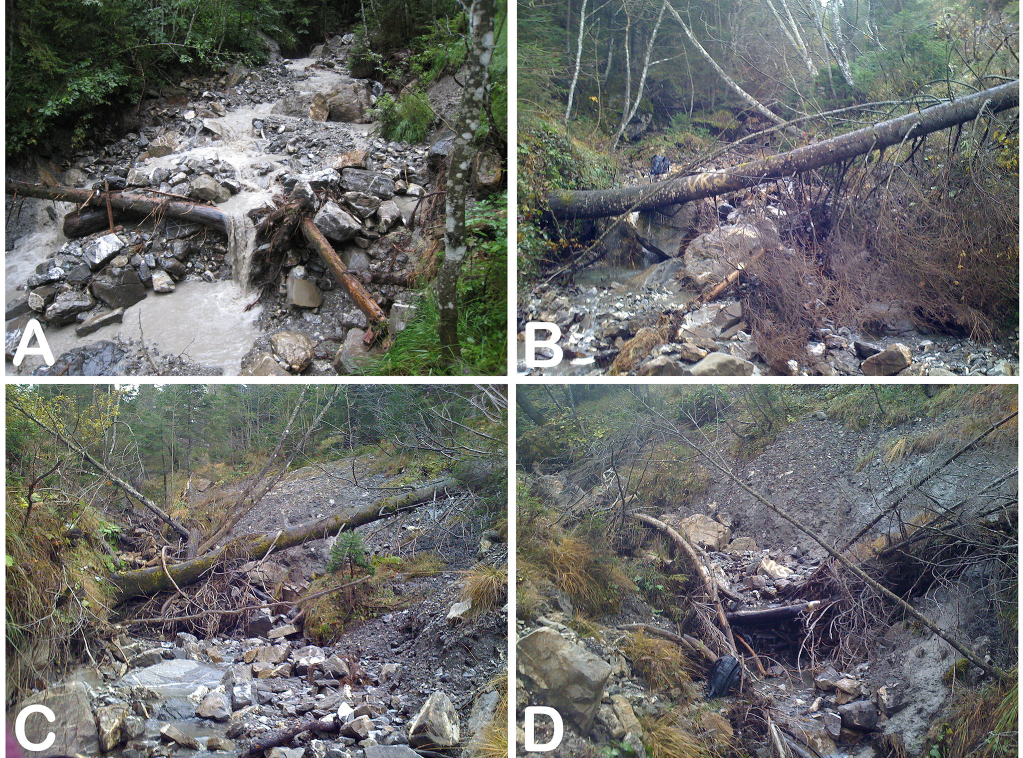
Figure 5. Four example log jams in the study reach: LJ1 (a) , LJ2 (b) , LJ4 (c) , LJ5 (d) . For the positions and characteristics of the jams within the study reach refer to Fig. 4 and Table 3. Each log jam shows a distinct key piece blocking the channel, thereby being responsible for the upstream accumulation of woody debris and